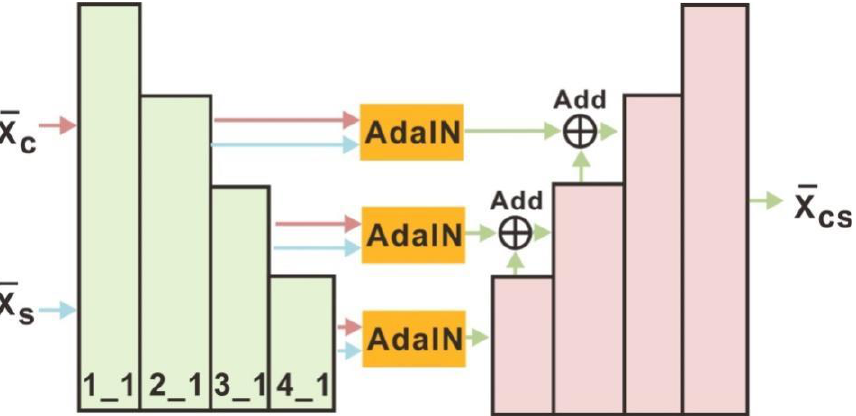
Figure 4. Schematic diagram of drafting network [29]. After double down-sampling, the content − − image x c and the style image x s are extracted from the corresponding granularity features at the 1_1, 2_1, 3_1 and 4_1 layers. Then the features of the content and output of each layer of the AdaIN module are aggregated through an encoder–decoder AdaIN module. Finally, in each granularity of the decoder, the corresponding features are merged from the AdaIN module through the jump connection layer.